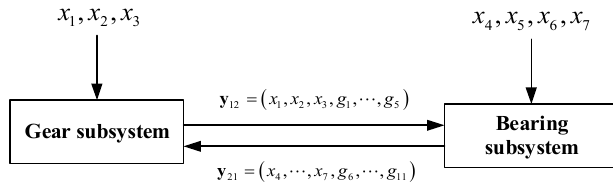
Figure 9. The coupling relationship diagram of speed reducer.